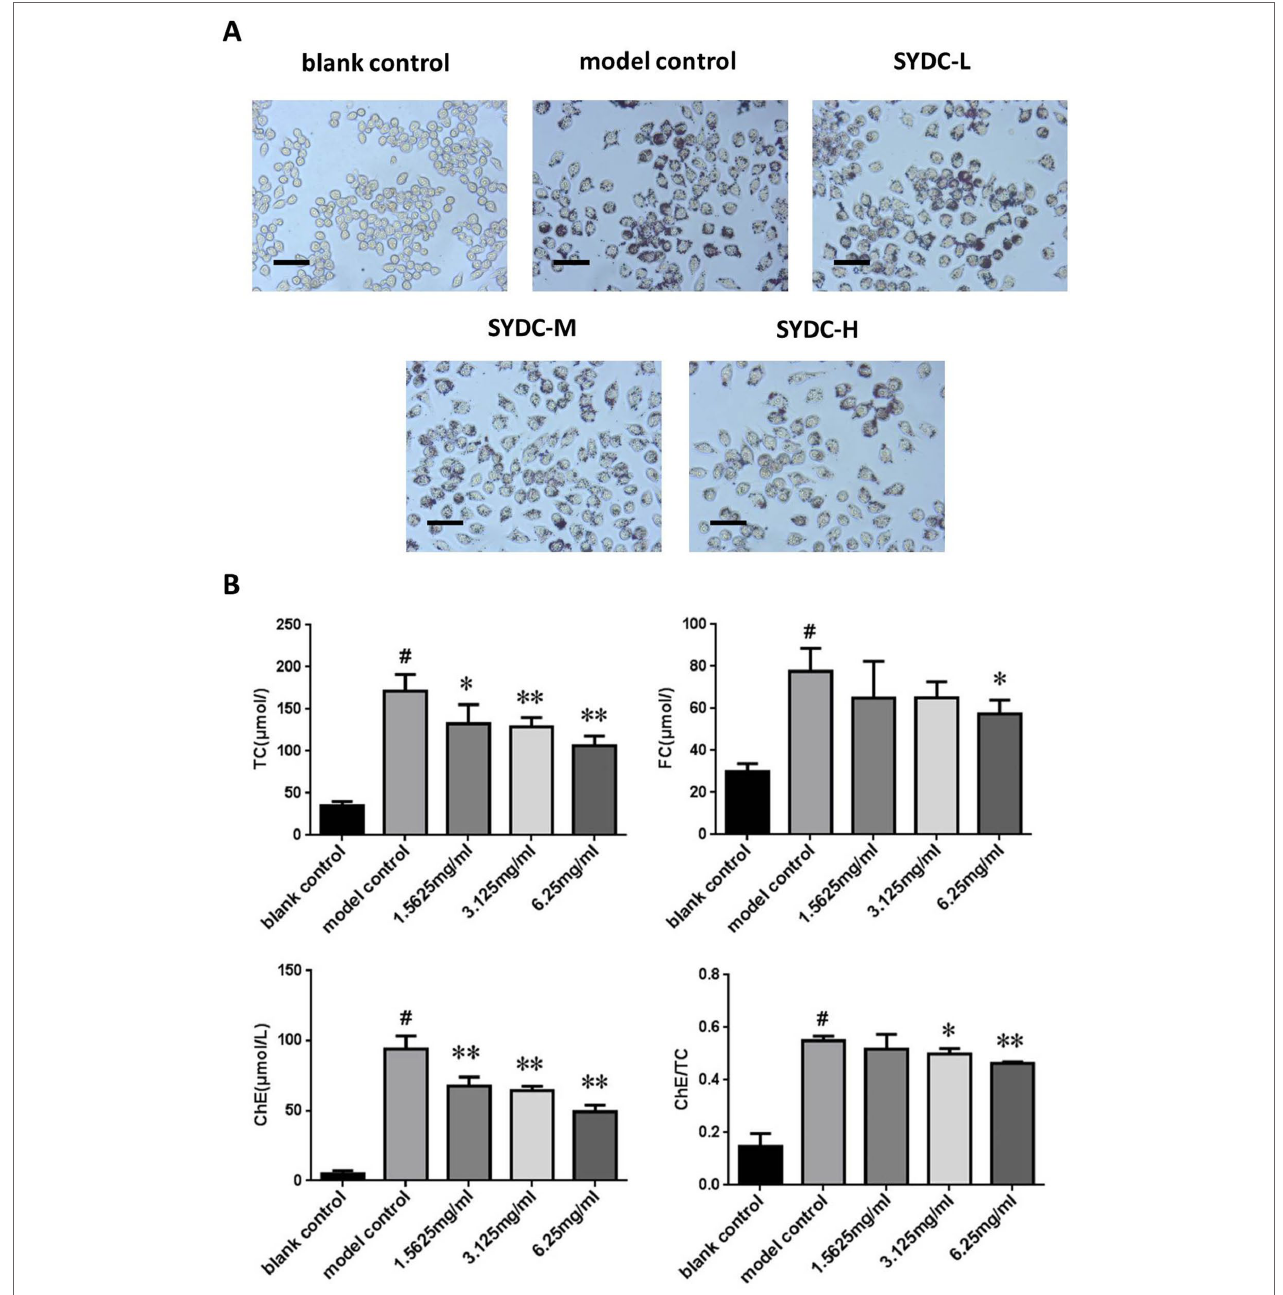
FIGURE 5 | Effects of SYDC on the levels of total, free, and esterified cholesterol in ox-LDL-stimulated RAW264.7 cells. (A) Representative images of Oil red O-stained lipid droplets. Cells were examined by light microscope (Scale bars = 50 μm). (B) Effect of SYDC on the levels of total, free, and esterified cholesterol in ox-LDL-stimulated macrophages. The cells were treated with various concentrations of SYDC. TC, total cholesterol; FC, free cholesterol; ChE, cholesterol ester. Values are represented as mean ± SD, n = 3. # P < 0.01 vs. blank control group alone; * P < 0.05 vs. model control group alone, ** P < 0.01 vs. model control group